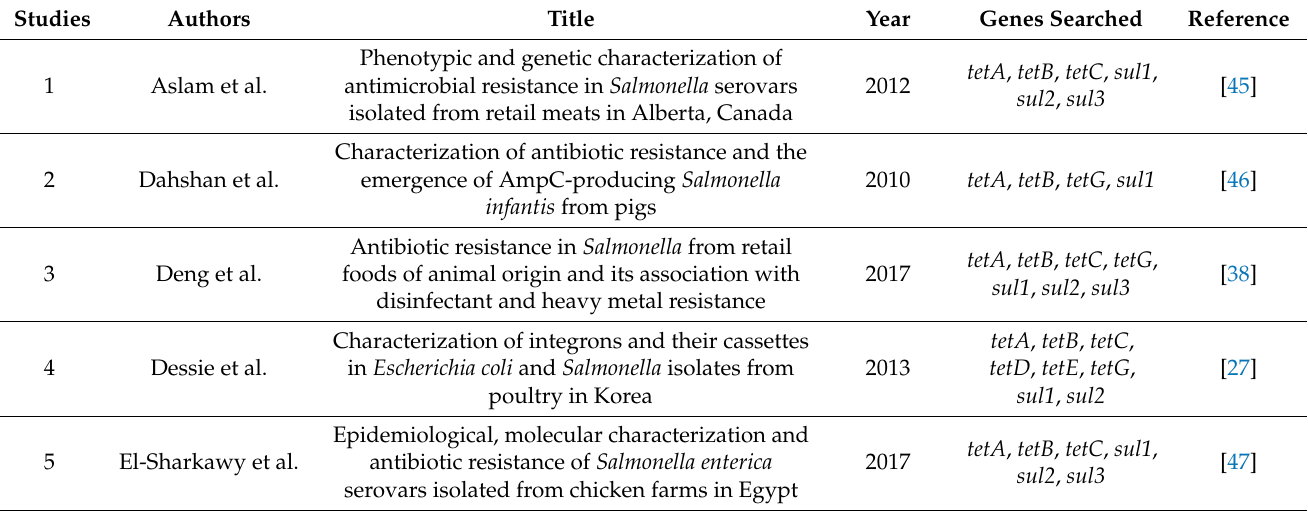
Table 1. Summary of studies with tetracycline and sulfonamide resistance genes in Salmonella